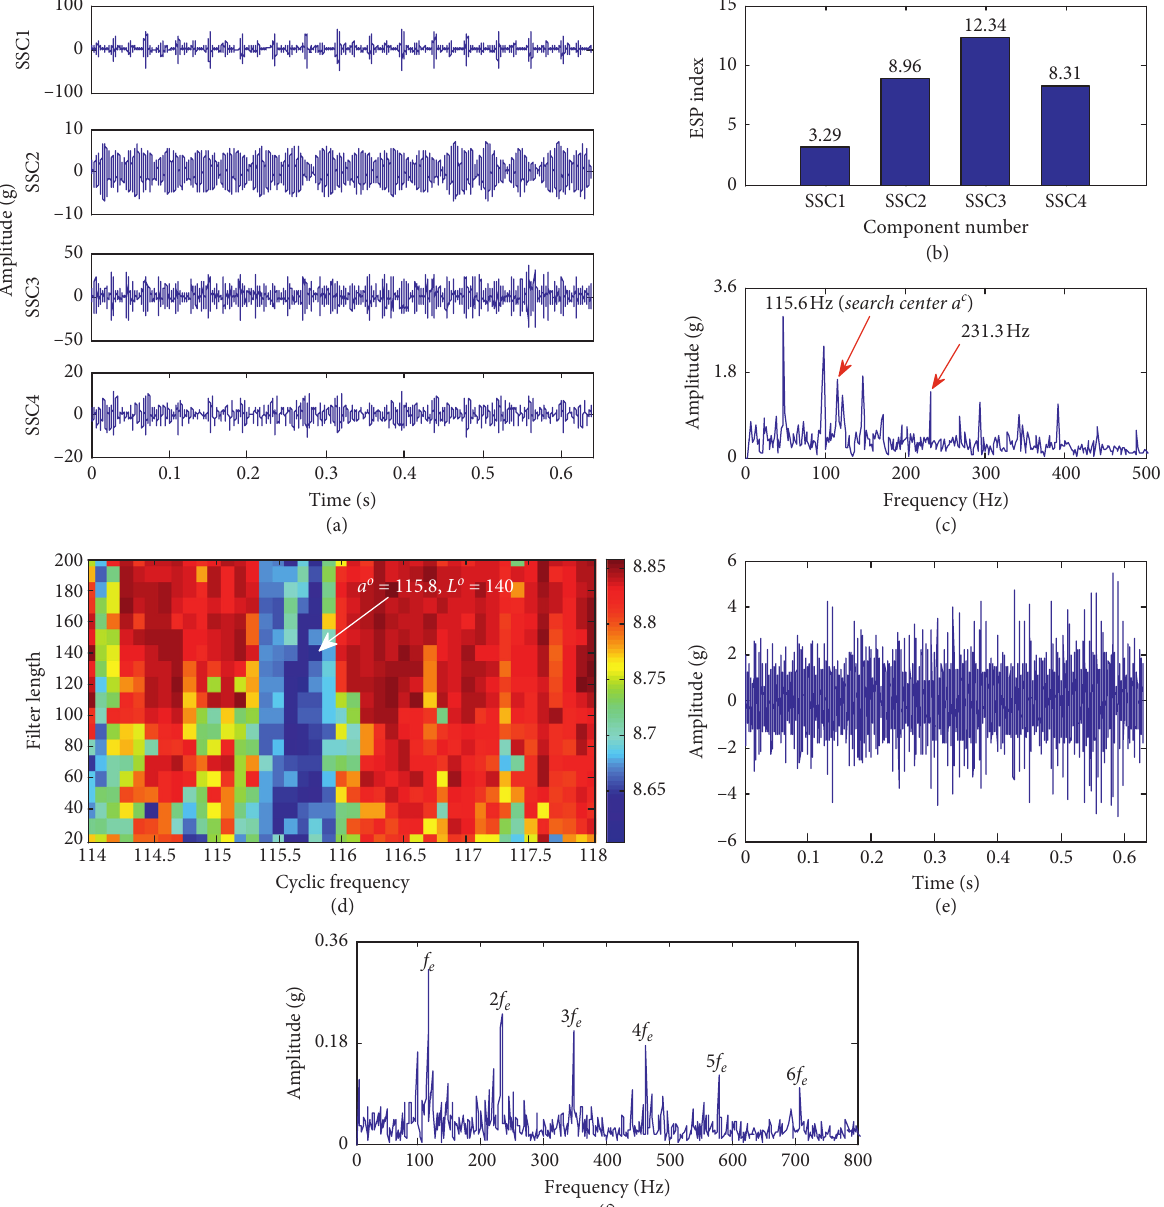
Figure 12: Analysis results of experimental signal by the proposed strategy: (a) the RSSD preprocessing results; (b) the ESP indexes of obtained components; (c) the envelope spectrum of SSC3; (d) the grid search result; (e) the waveform of deconvolution signal; (f) the envelope spectrum of deconvolution